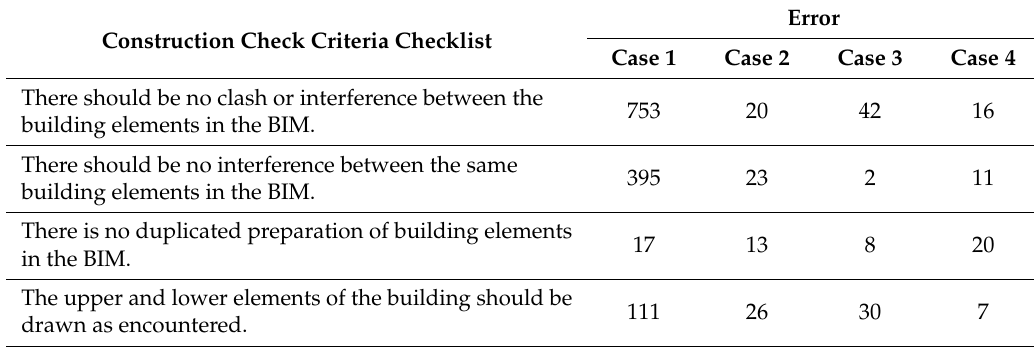
Table 13. The results of quality checks against the construction check criteria in case models.